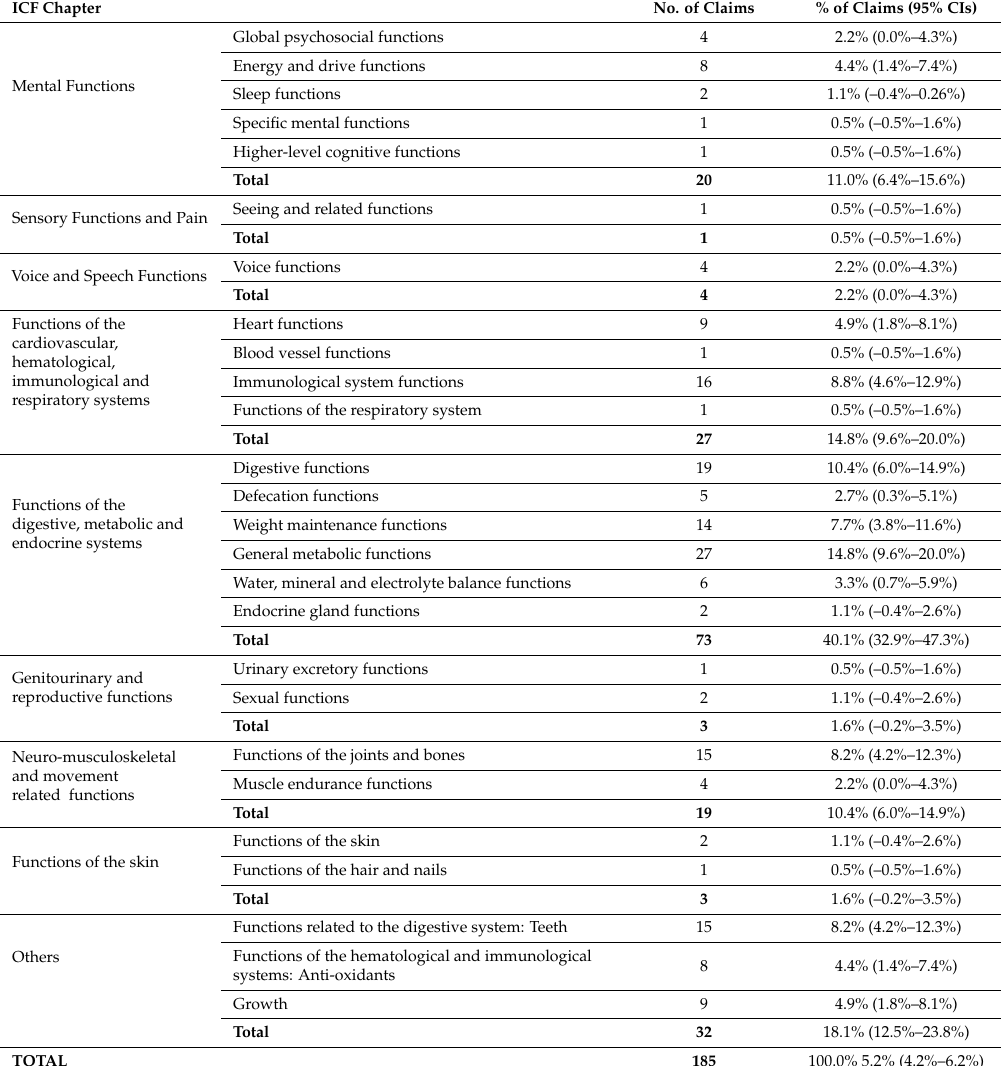
Table 5. Distribution of nutrient and other function claims by the International Classification of Functioning, Disability, and Health